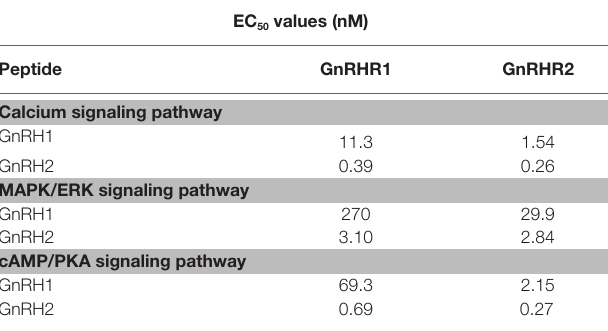
TABLE 2 | EC 50 values of chicken GnRH1 and GnRH2 in activating different signaling pathways of CHO cells expressing chicken